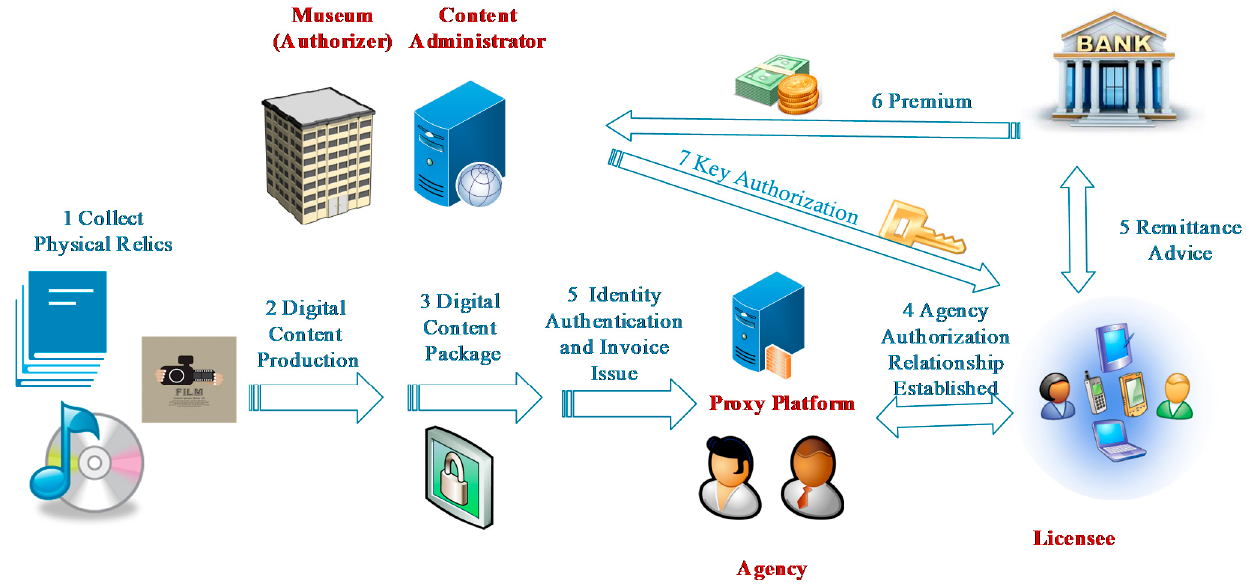
Figure 2. The digital direct authorization model of museum collections.